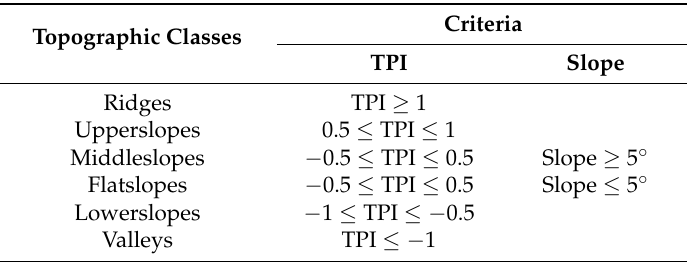
Table 1. Morphometric topographic classes calculated and ordered by Topographic Position Index (TPI) and slope